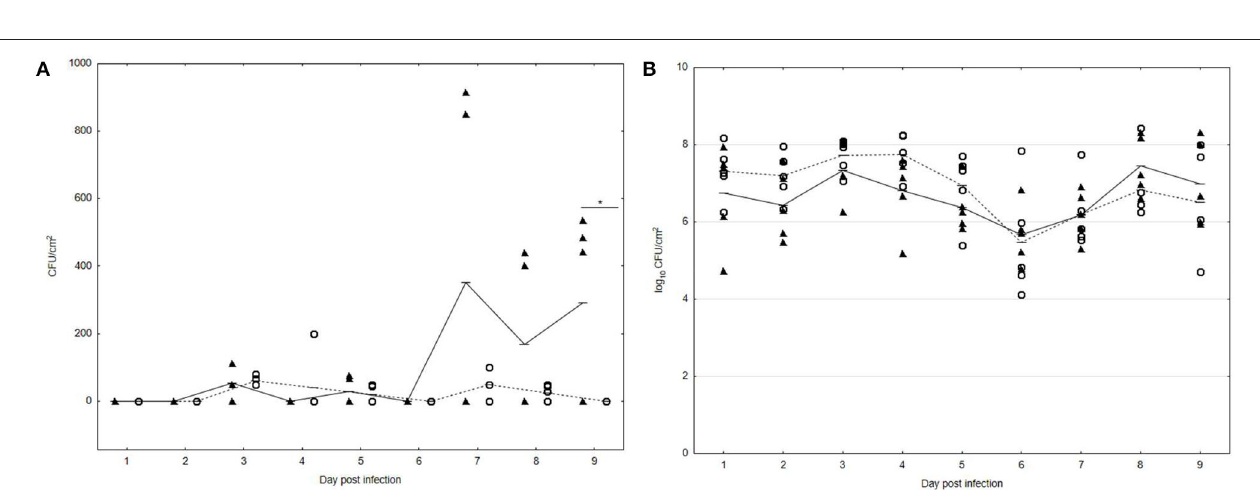
FIGURE 3 | Effectiveness of phage cocktail UPWr_S134 in reduction of S. Enteritidis 327 lux on poultry drinker surface. Effect of phage cocktail UPWr_S134 on the number of S. Enteritidis 327 lux in the LB (A) and LB diluted 10-fold (B) and water (C) . Values represent the mean with a standard deviation of three determinations. Black lines indicate the number of S . Enteritidis 327 lux on the drinker surface and gray dashed lines indicate the number of S . Enteritidis 327 lux on the drinker surface treated with phage cocktail UPWr_S134.